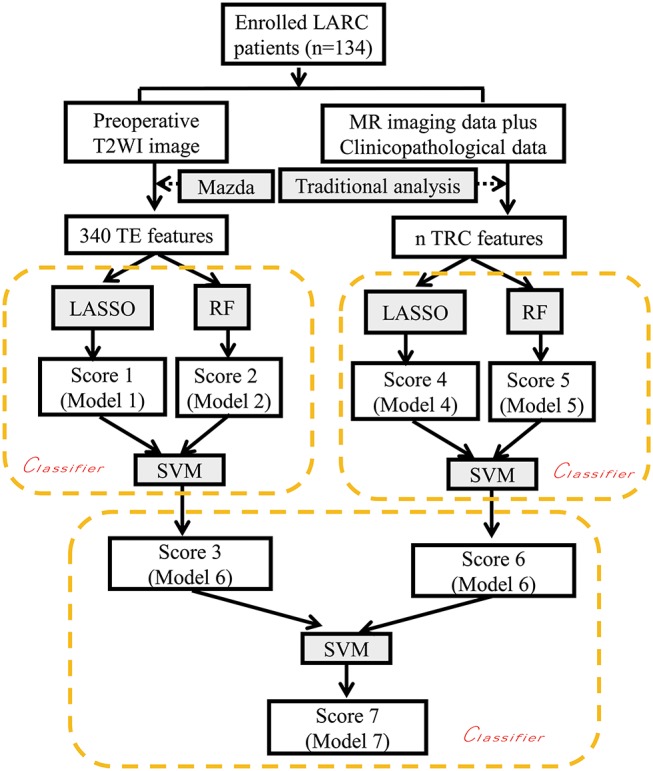
Flow chart depicting construction of the classification models. LARC, locally advanced rectal cancer; TE, texture features; TRC Traditional radiological features and clinicopathological features; LASSO, least absolute shrinkage and selection operator; RF Random forest; SVM support vector machine. The nx or ny terms used here indicate the different numbers of selected features used in the LASSO method with three different reduction schemes based on 340 TE features and 31 TRC features, respectively. The texture analysis software used was MaZda Version 4.6 (Institute of Electronics, Technical University of Lodz, Poland).